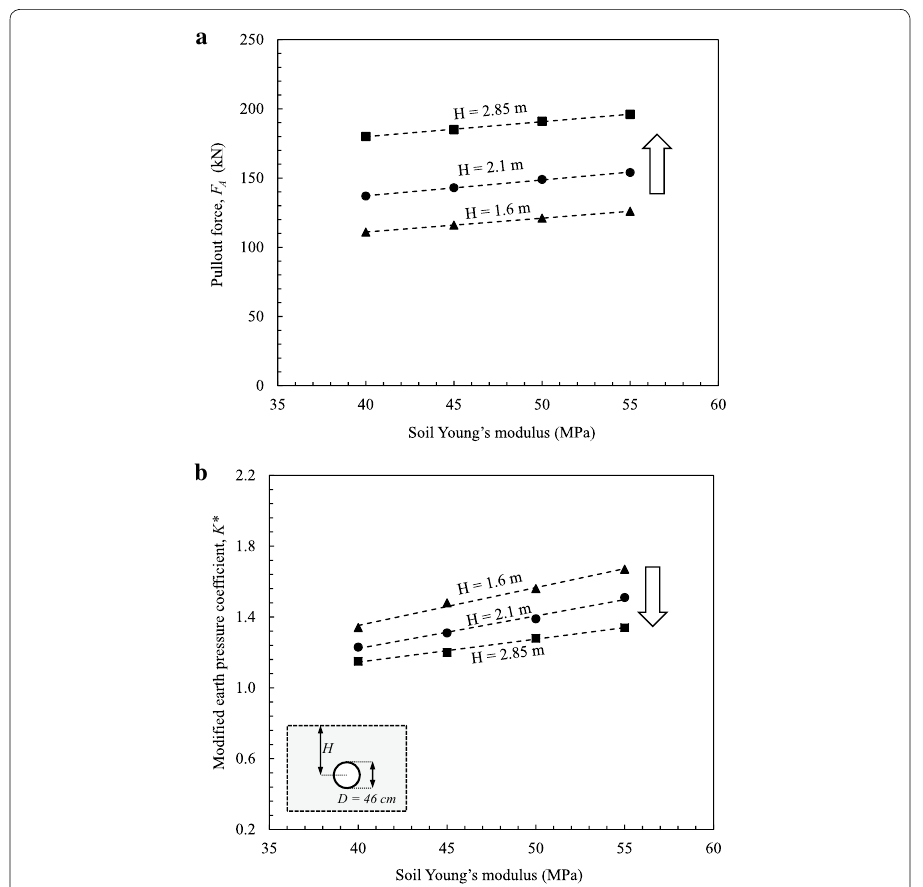
Fig. 7 Effect of soil modulus on: a pullout force; b modified earth pressure